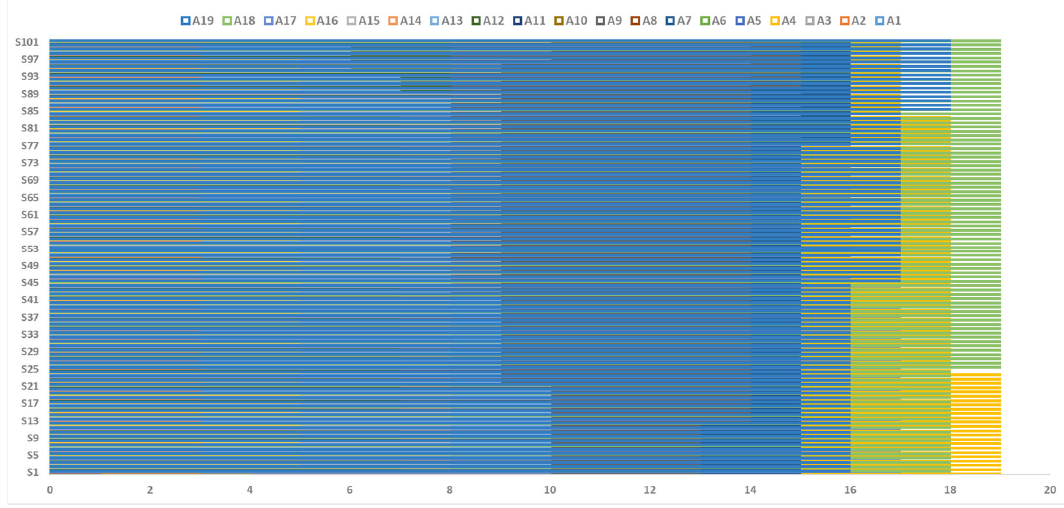
Fig. 3. Impacts of modifications of  parameter on the ranking results for 101